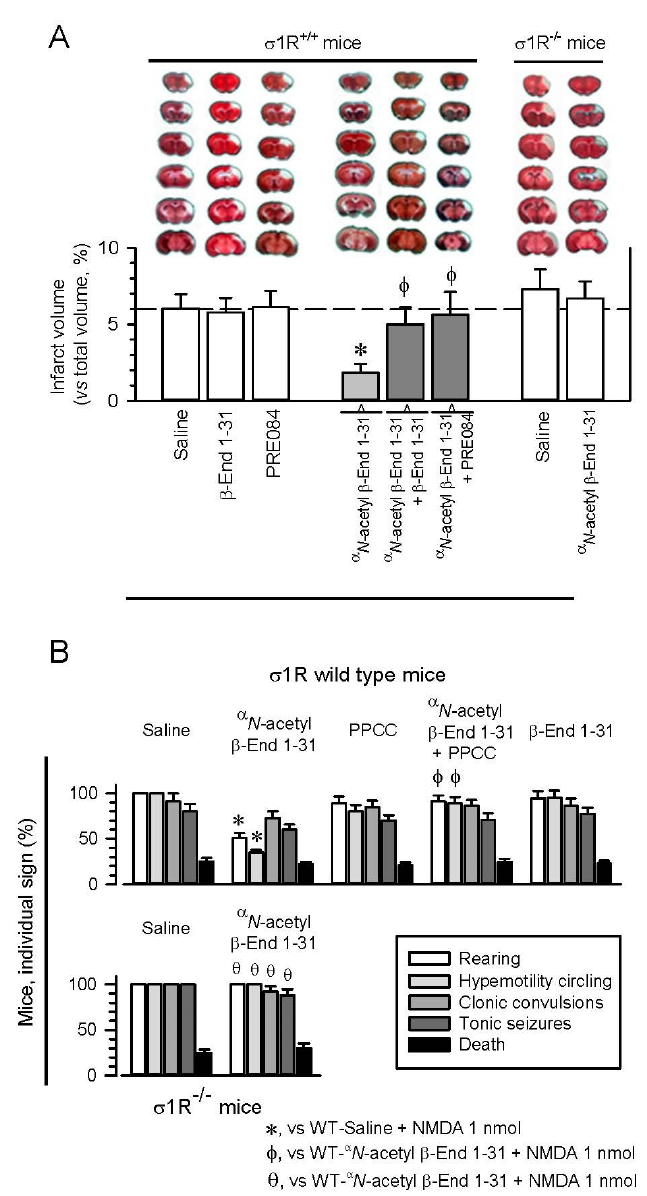
Figure 1. α N -acetyl β -End 1–31 reduced ischemic brain damage and diminished seizures induced by NMDAR overactivation. Implication of σ 1Rs. ( A ) α N -acetyl β -End 1–31 administration diminished ischemic brain damage in wild-type but not σ 1R − / − mice. Upper panel: representative 2,3,5- triphenyltetrazolium chloride (TTC)-stained brain section images obtained from saline- and drug- treated mice (3 nmol, 1 h after surgery) 48 h after pMCAO. White indicates infarction; red staining indicates normal tissue. Lower panel: the bar graphs quantitatively compare the infarct volume based on TTC staining from wild-type mice treated with saline, β -End 1–31 and the σ 1R agonist PRE084 (white bars). The reducing effect of α N -acetyl β -End 1–31 was counteracted by β -End 1–31 and PRE084 (gray bars). In σ 1R − / − mice, the positive effect of α N -acetyl β -End 1–31 was not observed. The groups consisted of five to eight mice, and the data are presented as the mean ± SD. * Significantly different from the saline-treated mice. φ Significantly different from mice receiving only α N -acetyl β -End 1–31; ANOVA followed by the Holm–Sidak multiple comparisons test, p < 0.05, 1- β > 0.80. ( B